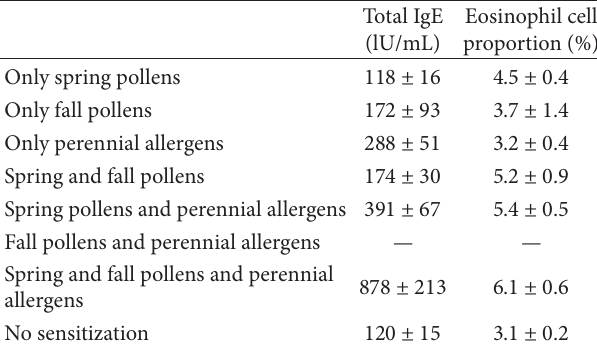
Figure 1: The rate of sensitization (determined by RAST) to Japanese cedar, Japanese cypress, and mites was affected by the patient’s age. Black arrow head, gray arrow head, and black arrow show the peaks of each rate, respectively. Table 2: Serum total IgE and blood cell eosinophil.